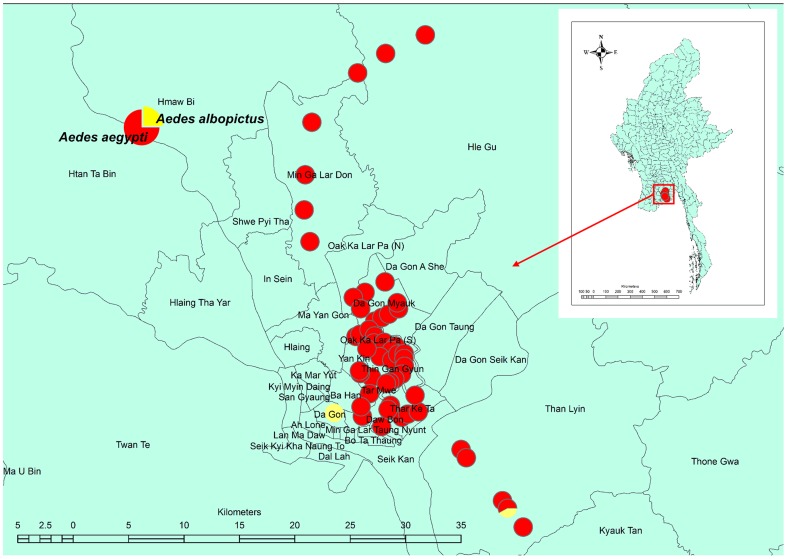
Distribution of Aedes aegypti and Aedes albopictus larvae.The larvae were collected from used tires in Yangon City. Each circle indicates the species composition of the two species.